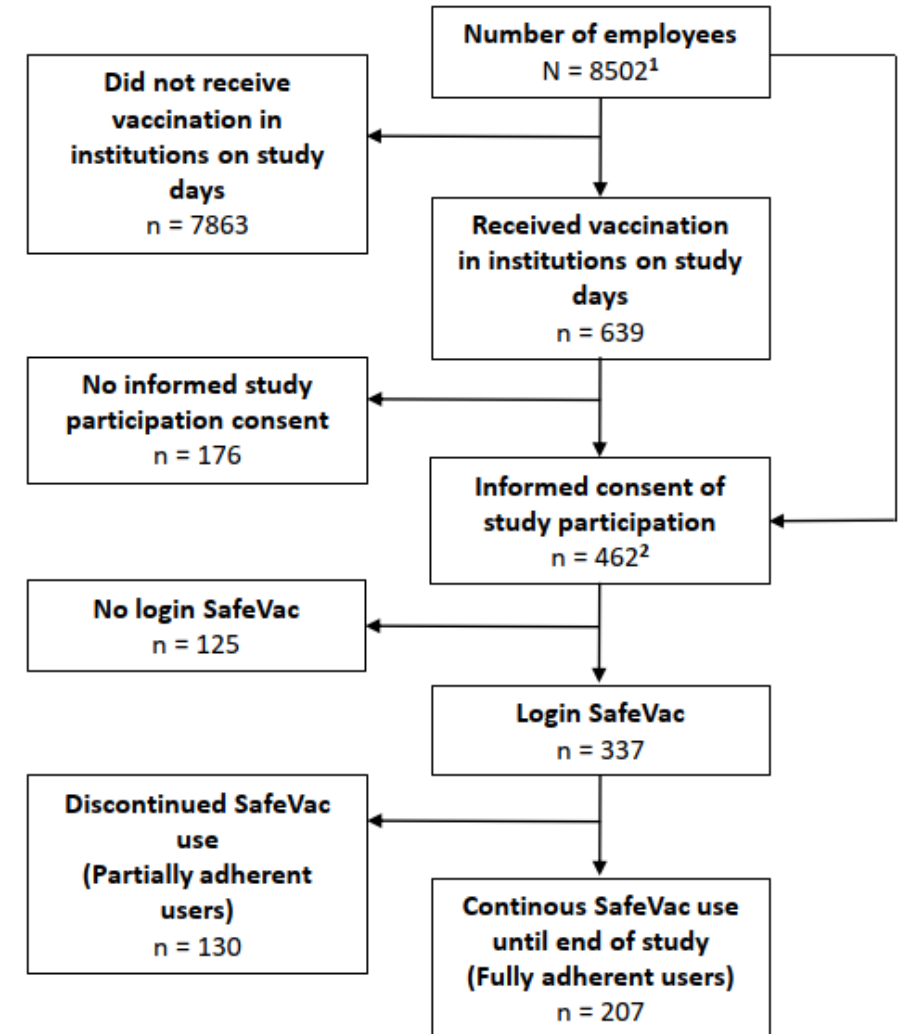
Figure 2. Study participant recruitment. 1 Obtained through personal communication and estimates based on institutional website; for PEI and IBB only ≥ 18 years old included; 2 included participants who were vaccinated before study